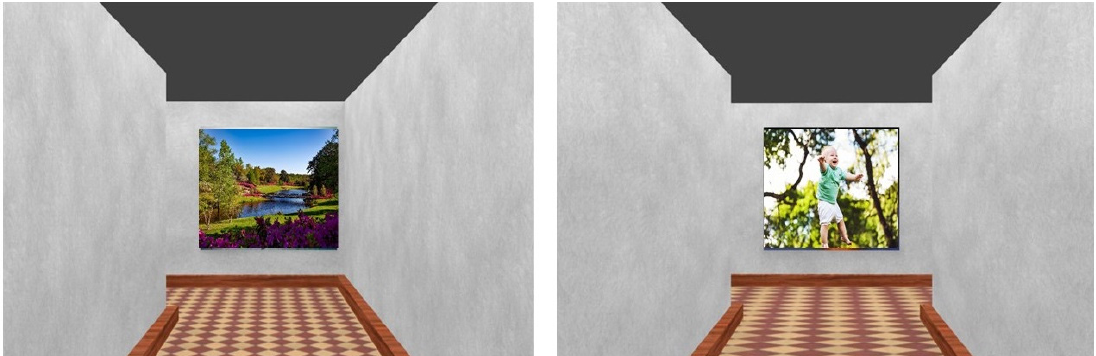
Figure 2. The figure depicts two examples (on the right and left) of participants’ first view perspective during the navigation of the route. Note: the images on the route’s wall are copyright ‐ free images